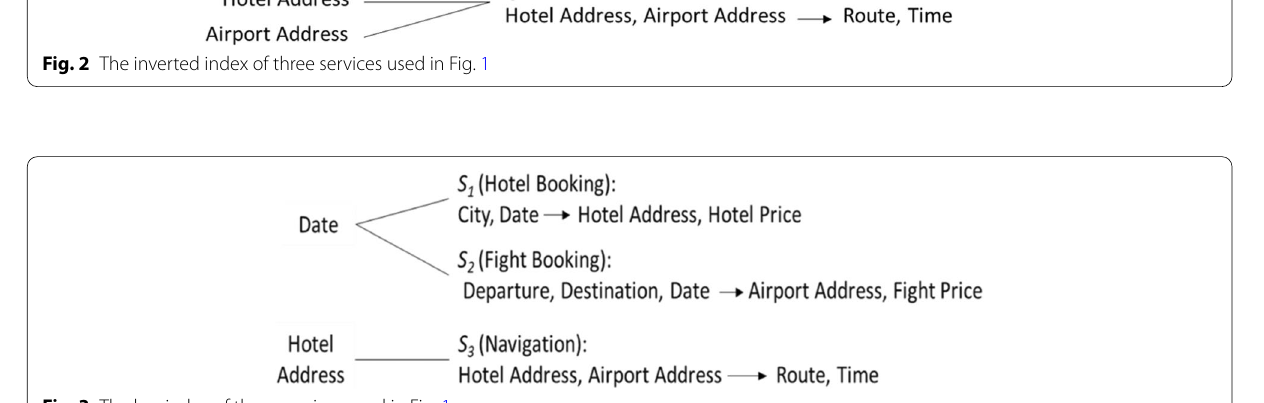
Fig. 3 The key index of three services used in Fig. 1